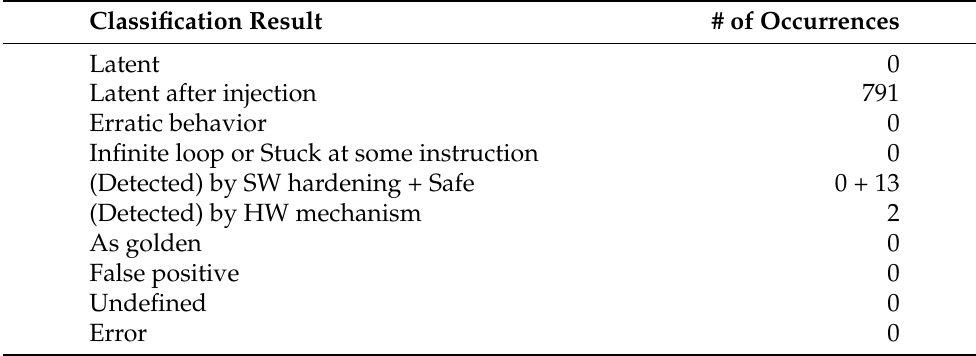
Table 4. Classifier results obtained from the fault injection campaign assessing the YACCA algorithm implemented on tank